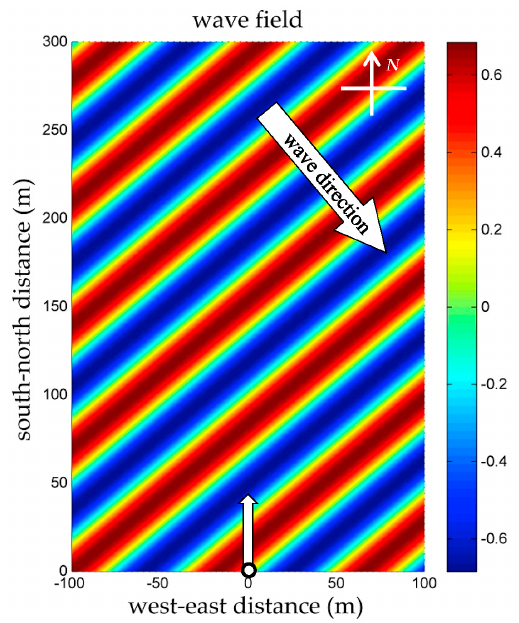
Figure 4. Top view of regular wave field, T = 5.85 s and L = 53.35 m. The radar’s location is (0, 0) and it transmits to the north. Wave direction is 140 degrees, measured clockwise from the north.